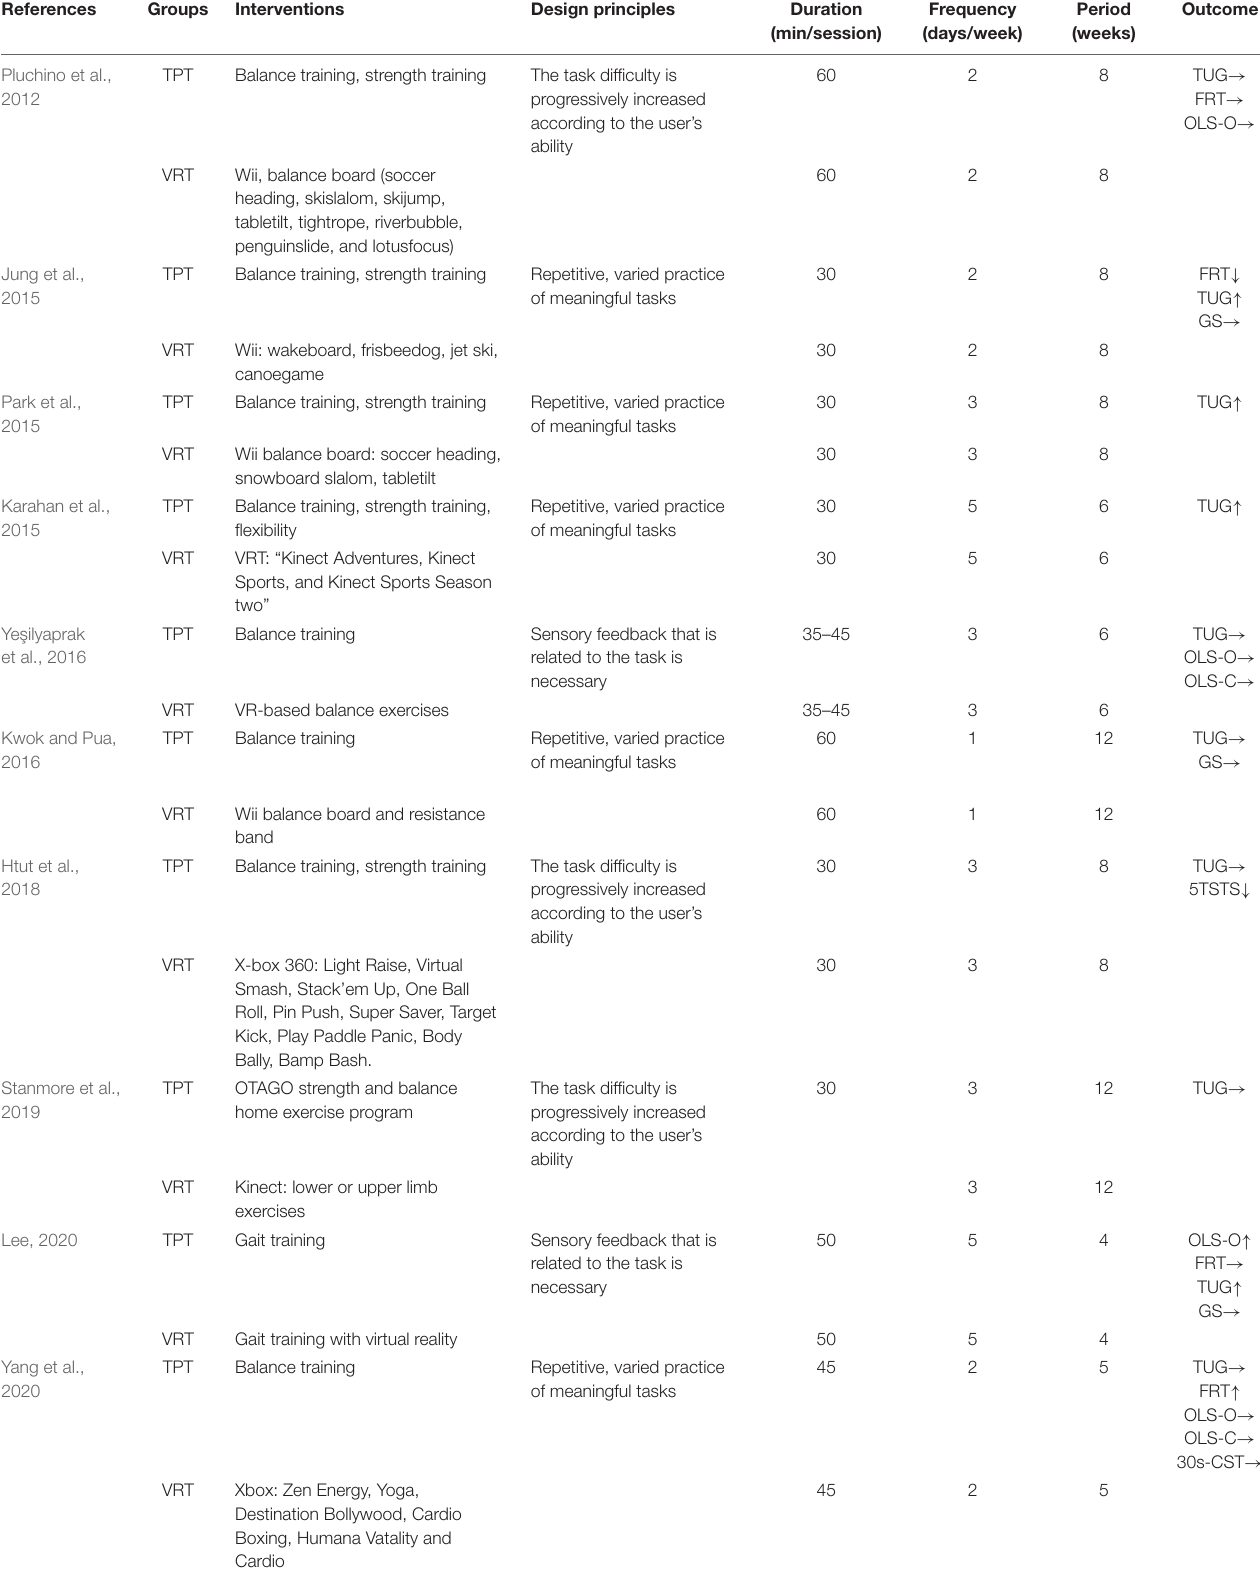
TABLE 2 | Characteristics of the interventional